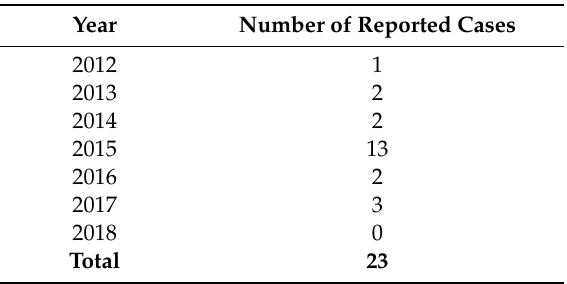
Table 1. Number of confirmed tularemia cases in Croatia 2012–2018, reported to the European Centre for Disease Prevention and Control